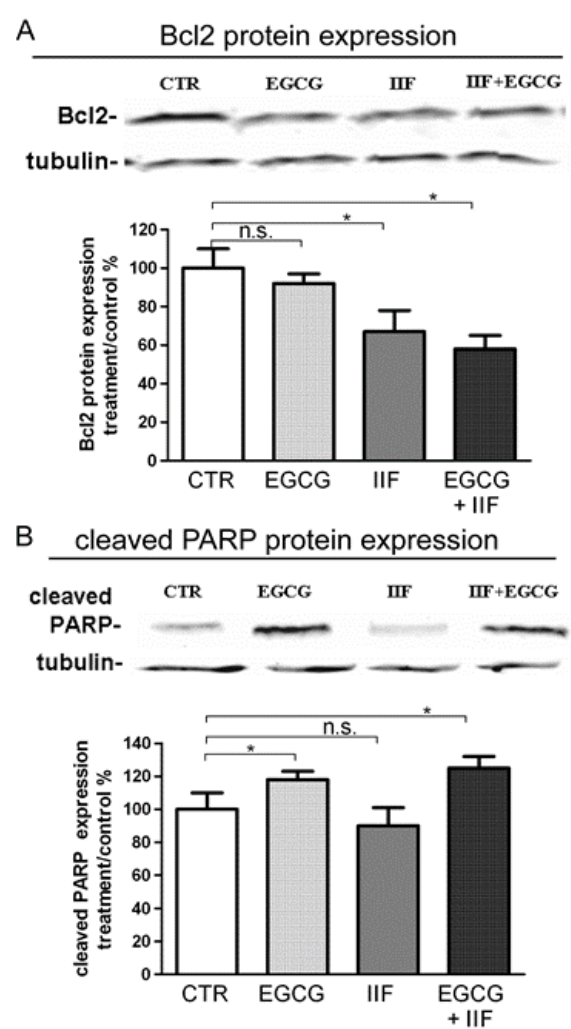
Figure 4. Effect of EGCG and IIF treatments on apoptosis-related proteins in BE(2)-C neuroblastoma cells. Modulation of Bcl-2 and cleaved PARP levels after 24 h individual and combined 20 µ g/mL EGCG and 10 µ M IIF treatments. Proteins (50 µ g) from total cell lysates were subjected to SDS–PAGE and Western blot analysis while using Bcl-2 ( A ) and cleaved PARP antibodies ( B ). The values were normalized to the untreated controls. β -tubulin was used as a loading control. The results are expressed as the average ± SE of three independent experiments. * p < 0.05. n.s.: not significant.